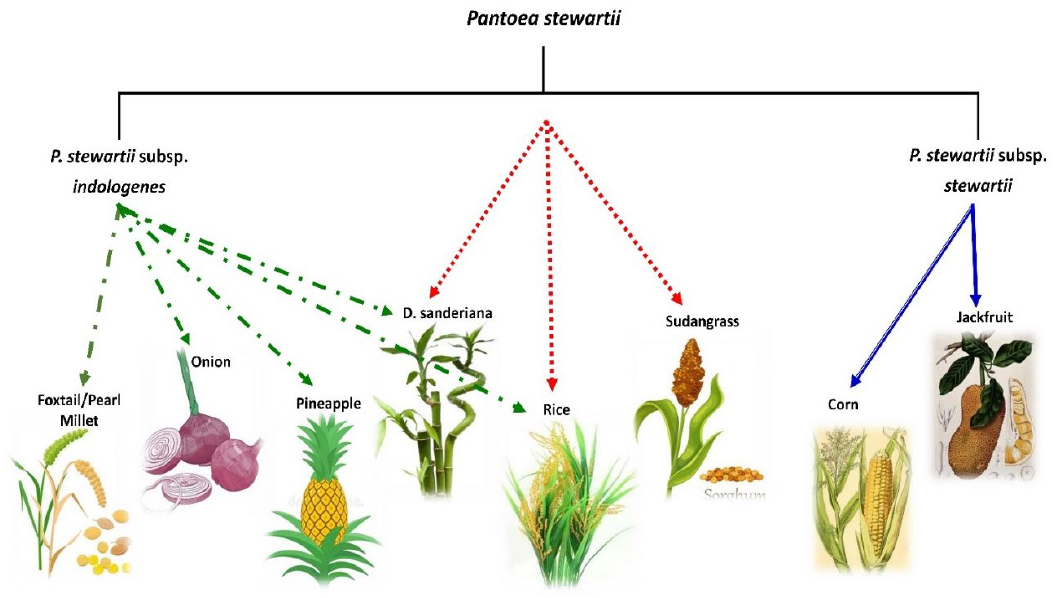
Figure 4. Host plants of the phytopathogens P. stewartii , P. stewartii subsp. indologenes , and P. stewartii subsp. stewartii. Pantoea stewartii (red dotted arrows) causes leaf blotch of Sudan grass, Stewart’s wilt of D. sanderiana and BLB of rice ( O. sativa ); P. stewartii subsp. indologenes (green dotted arrows) causes rot of pineapple ( A. comosus ), leaf spot of millets ( S. italic and P. americanum ), center rot disease of onion ( A. cepa ), leaf blight wilt of D. sanderiana and BLB of rice ( O. sativa ); P. stewartii subsp. stewartii (blue arrows) causes Stewart’s wilt of corn and bronzing disease of jackfruit ( A. heterophyllus).